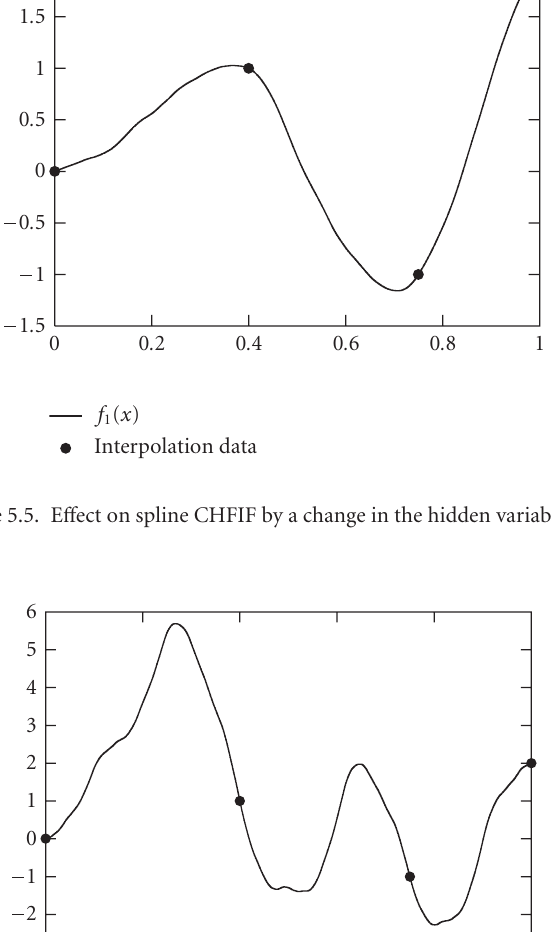
n = 1,2, ... , N , where a n can be calculated from the given interpolation data. The